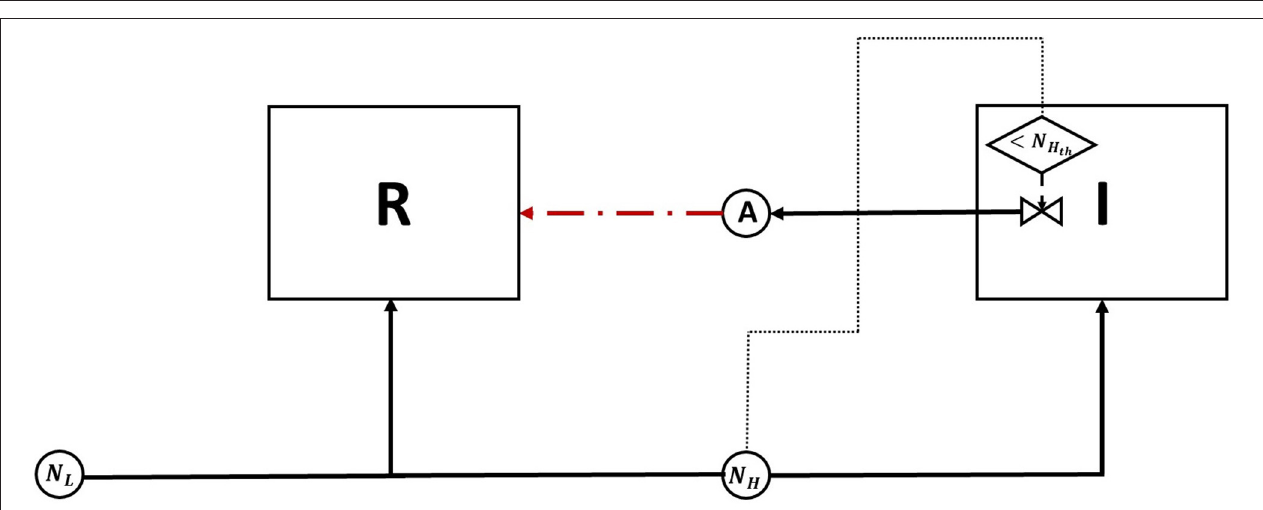
FIGURE 5 | A diagram of the competition between an antibiotic producing invader and a resident species, competing over a high value nutrient, N H . While consuming the high value nutrient is the optimal growth strategy for the resident species in absence of a antibiotic producing opponent, niche segregation by switching to consuming the low value nutrient, N L , is the optimal response when competing with such opponent, as it would avoid triggering nutrient stress regulated antibiotic release by the invader. See Figure 2 legend for an explanation of the diagram’s